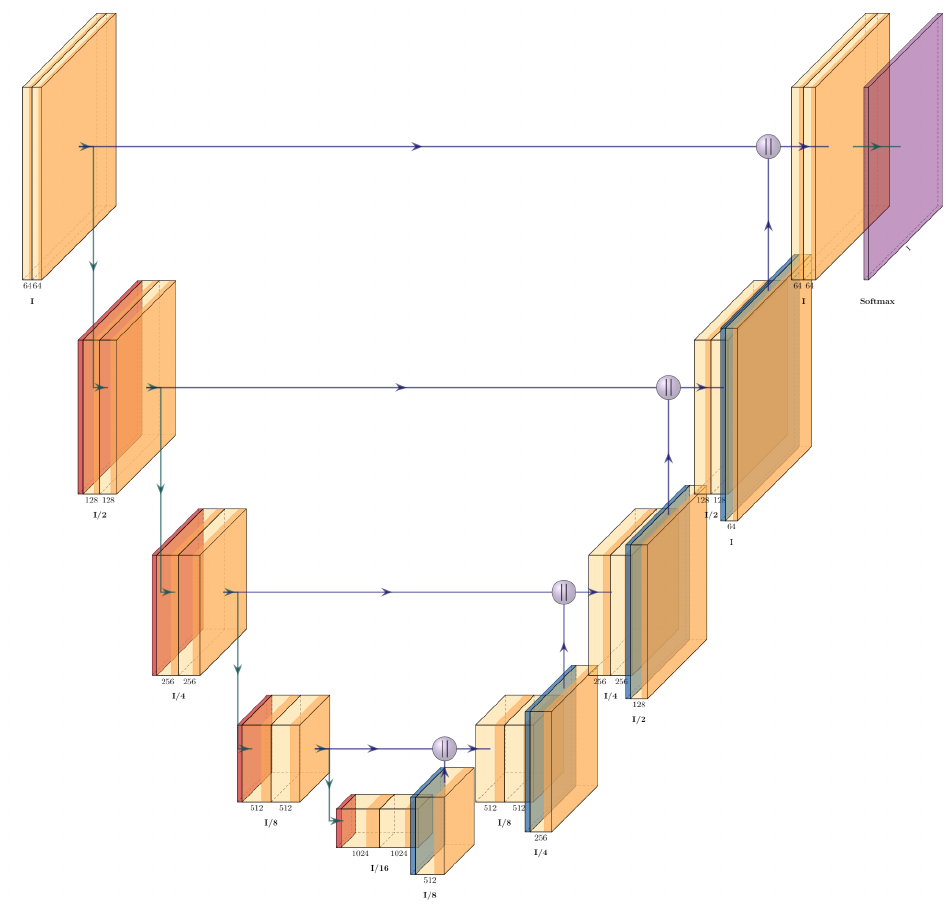
Figure 1. U-NET U-shaped architecture represented using algorithms from